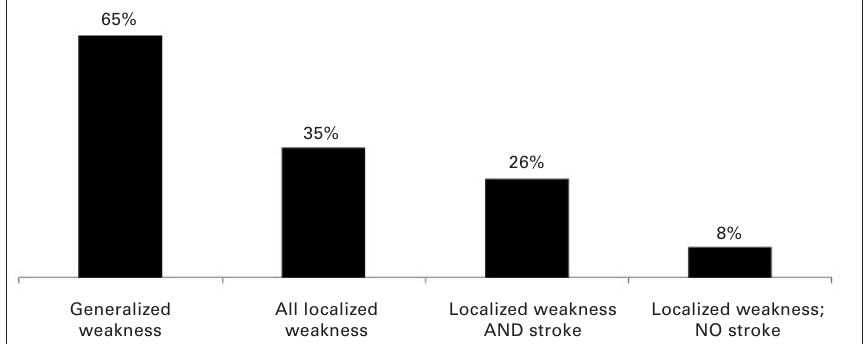
Spectrum of 121 consecutive patients admitted to the ED with weakness.